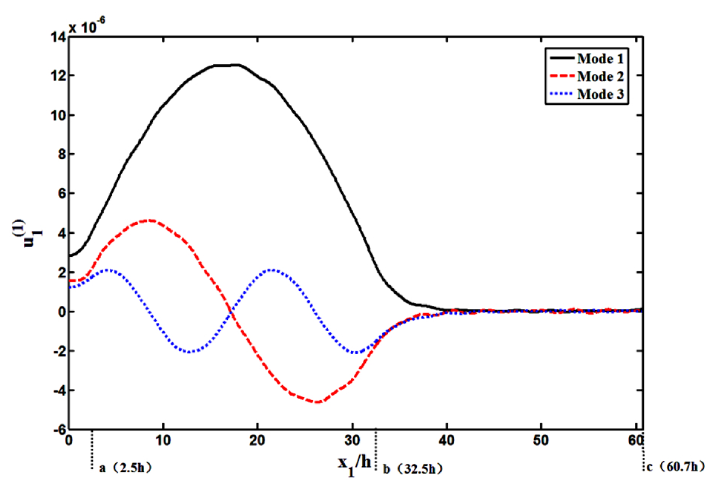
( 1 )   1 ) near resonance. Crystals 2020 , 10 , x FOR PEER REVIEW 9 of 14 u 1 1 ) near resonance.